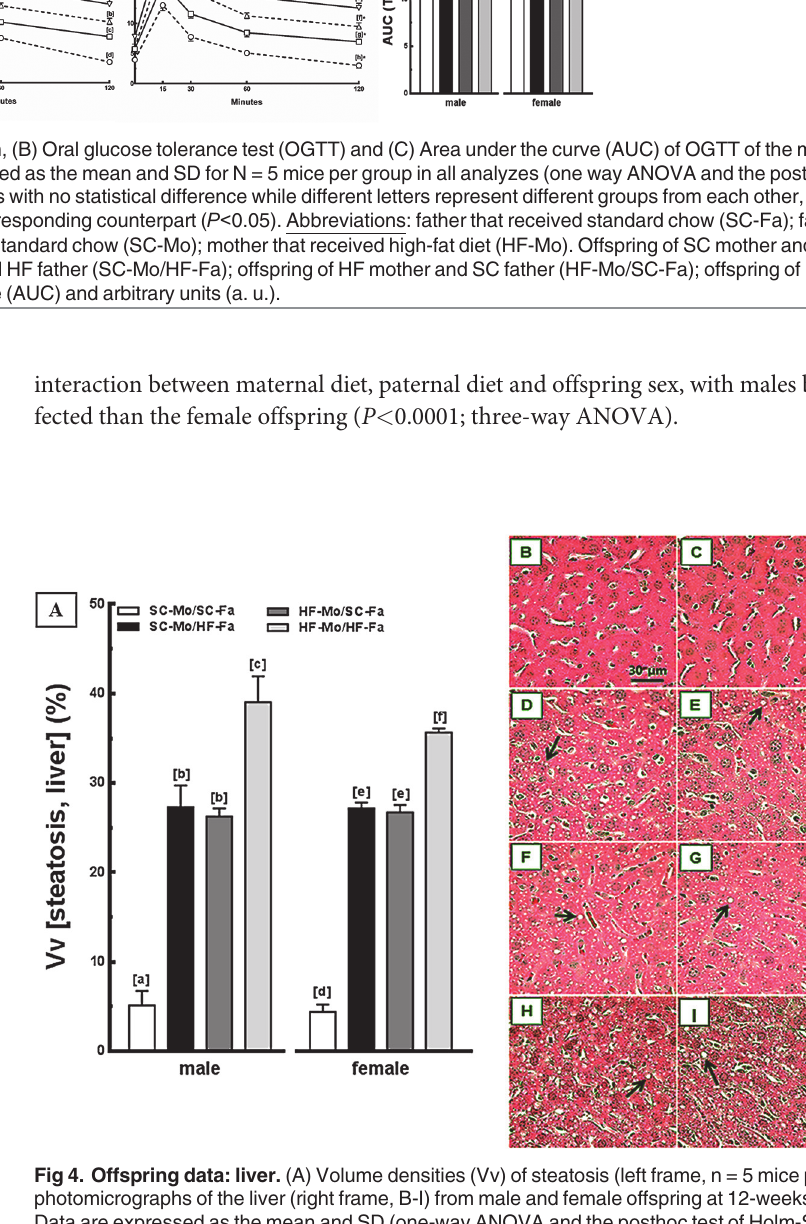
Fig 4. Offspring data: liver. (A) Volume densities (Vv) of steatosis (left frame, n = 5 mice per group) and photomicrographs of the liver (right frame, B-I) from male and female offspring at 12-weeks old (HE staining). Data are expressed as the mean and SD (one-way ANOVA and the posthoc test of Holm-Sidak). Same letters represent equal groups with no statistical difference while different letters represent different groups from each other, with statistical difference ( P < 0.05). Photomicrographs: B and C — male and female offspring of SC mother and SC father, respectively (SC-Mo/SC-Fa); D and E — male and female offspring of SC mother and HF father, respectively (SC-Mo/HF-Fa); F and G — male and female offspring of HF mother and SC father, respectively (HF-Mo/SC-Fa); H and I — male and female offspring of HF mother and HF father, respectively (HF-Mo/HF-Fa). Offspring of obese mother or obese father and both obese parents present numerous hepatocytes with fat droplets